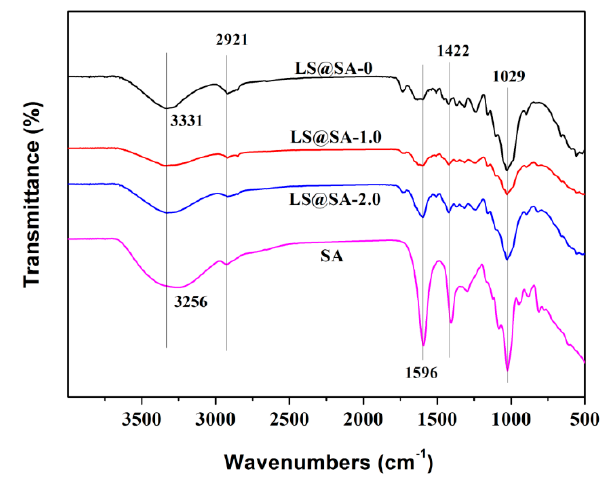
Figure 4. FTIR spectra of selected samples.